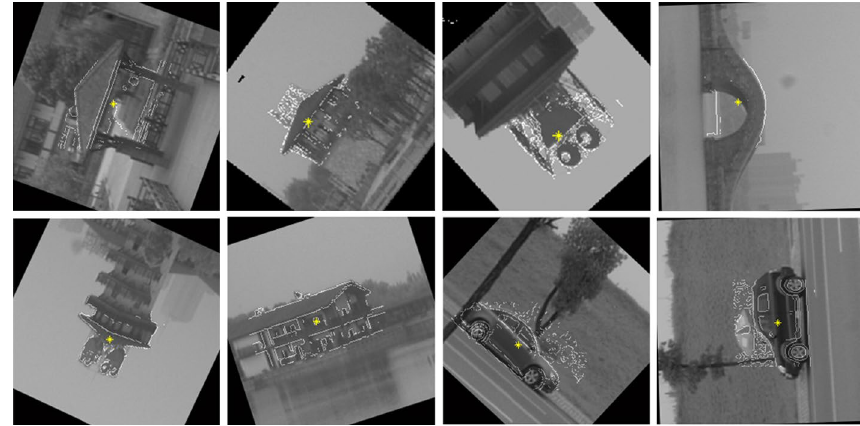
Fig. 16 Matching results under rotational changes